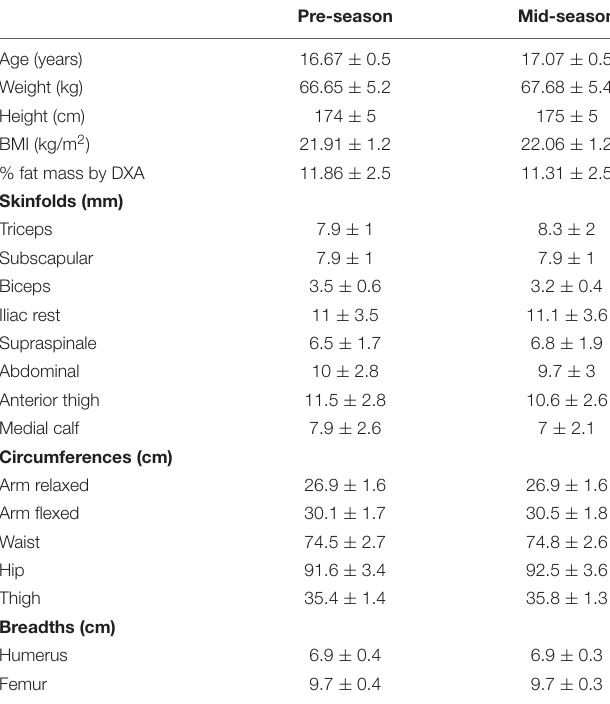
TABLE 1 | Physical characteristics of the participants ( n =